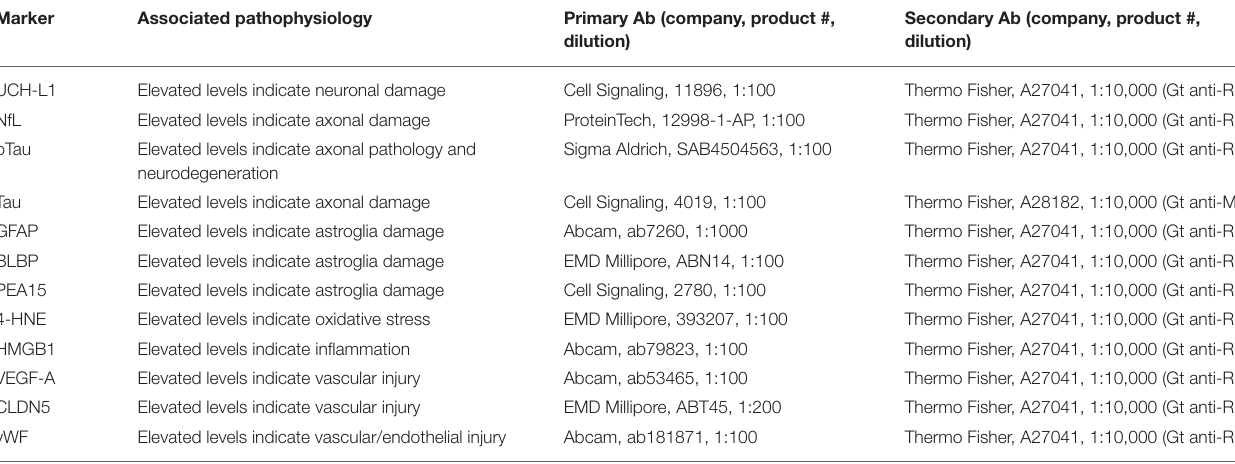
TABLE 1 | List of serum proteins, associated pathophysiology, and antibody details for RPPM analysis.